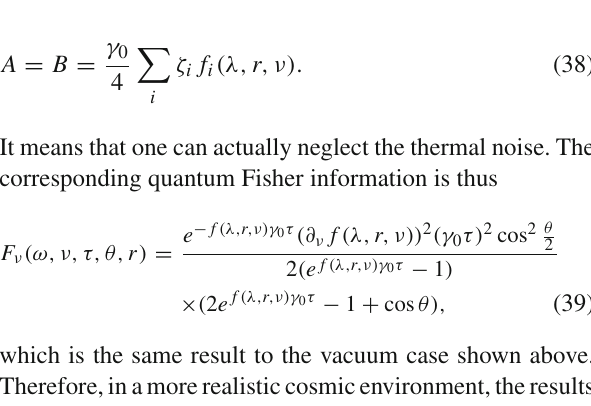
, and τ is in the unit 0